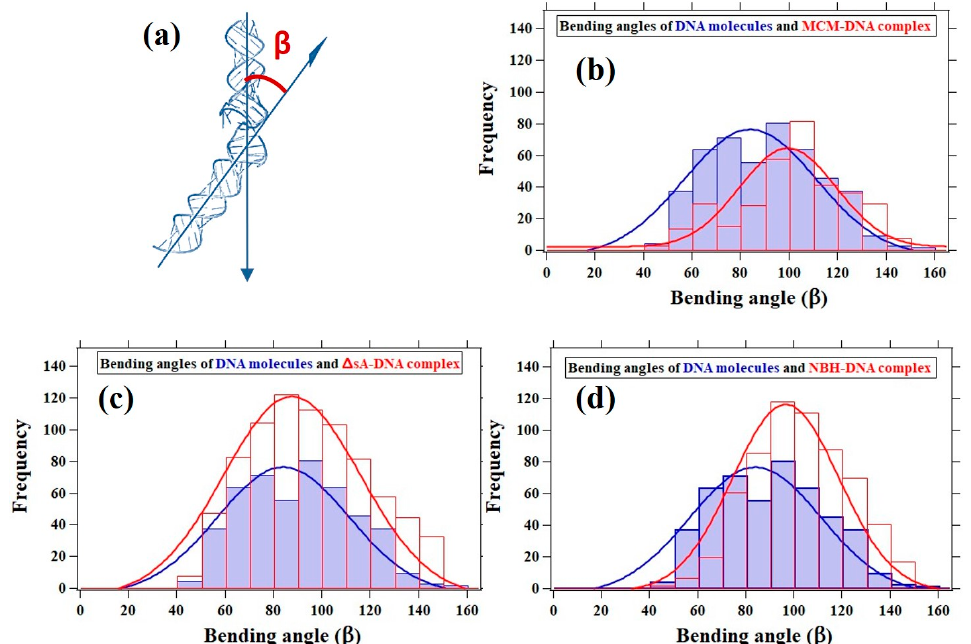
Figure 7. Histograms of the bending angles characterizing the bare DNA (blue distribution), which is 84° and protein- mediated DNA kinks (red distribution). ( a ) The bending angle ( β ), ( b ) for the MCM–DNA complex, the distribution is centered around 100° shifted by 16° comparing to the bare DNA distribution; ( c ) ∆ sA–DNA complex, behaving as bare DNA; and ( d ) NBH–DNA complex, the distribution centered around 97°, which is close to the MCM–DNA distribution.